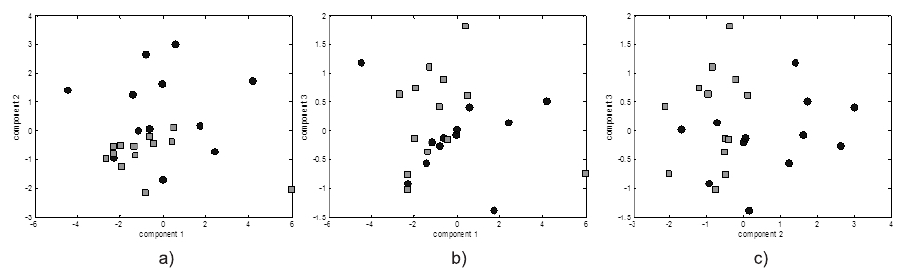
Figure 8. Observations from treatment group divided into groups of time from end of treatment on principal component